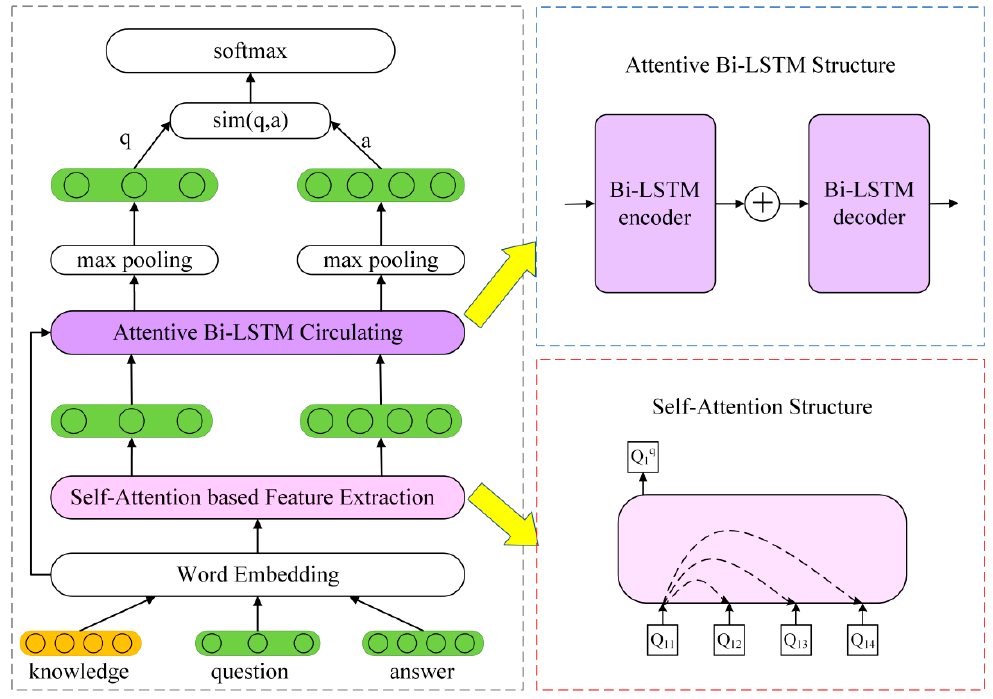
Figure 2. The architecture of proposed answer selection method.